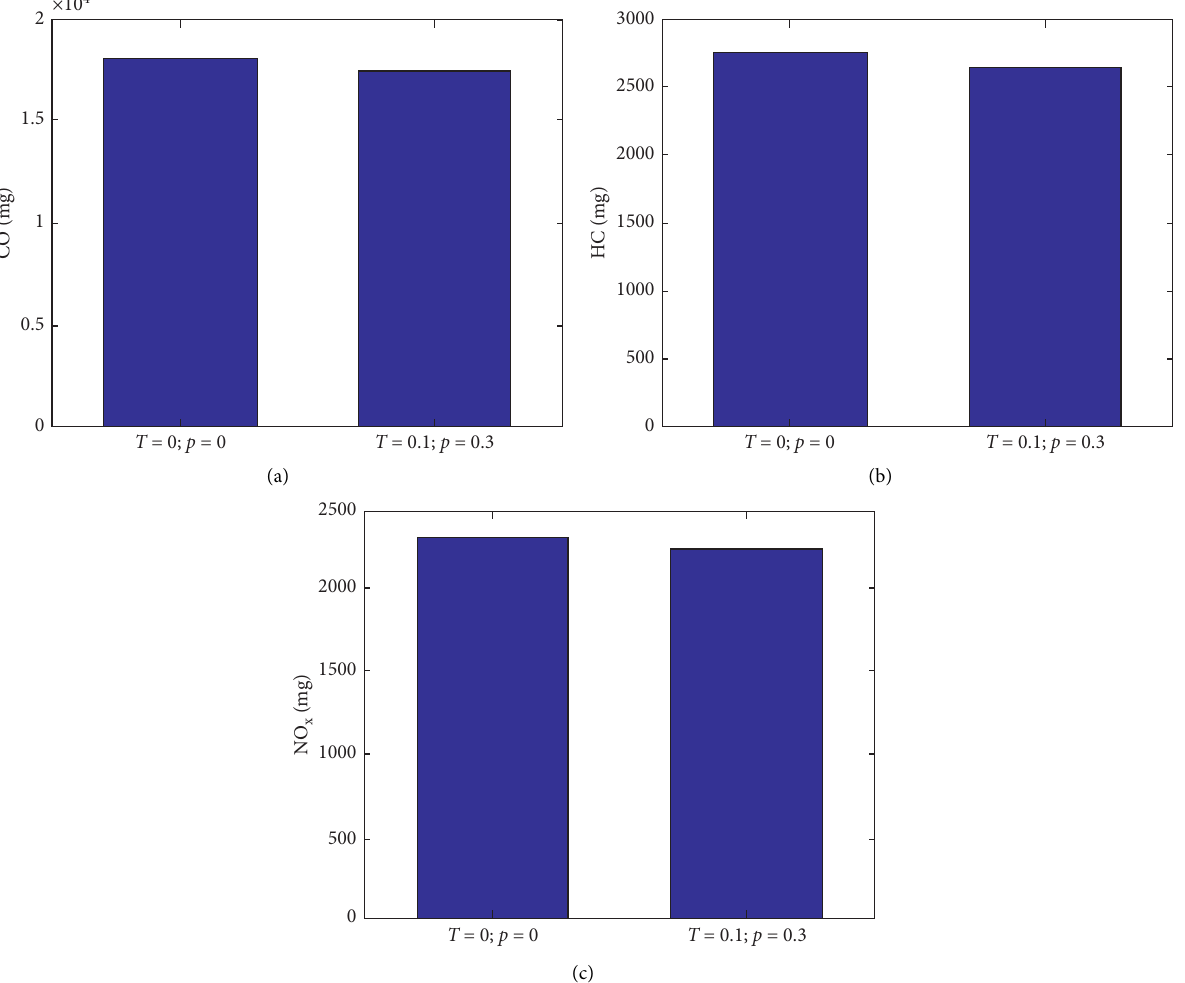
Figure 15: The total CO, HC, and NO � 0, p � 0) and the AAFVD model ( T � 0.1, x emission of 10 vehicles simulated by the AFVD model ( T p � 0 . 3) during departure and arrival process: (a) CO, (b) HC, and (c) NO x